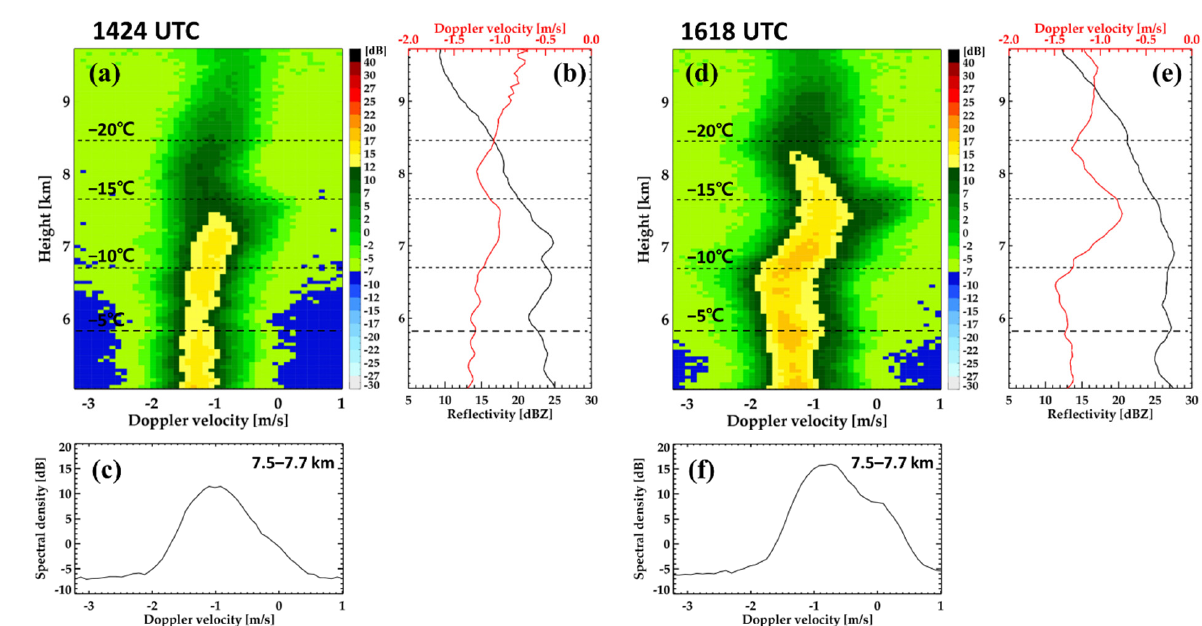
Figure 12. ( a , d ) Doppler power spectra at different heights, ( b , e ) vertical profiles of Z and V D , and ( c , f ) averaged Doppler power spectrum between 7.5–7.7 km observed from vertically pointing X-band radar at 1424 UTC and 1618 UTC on 5 July 2014. Positive (negative) velocity indicates upward (downward) motion. Dashed lines indicate temperatures from sounding data.